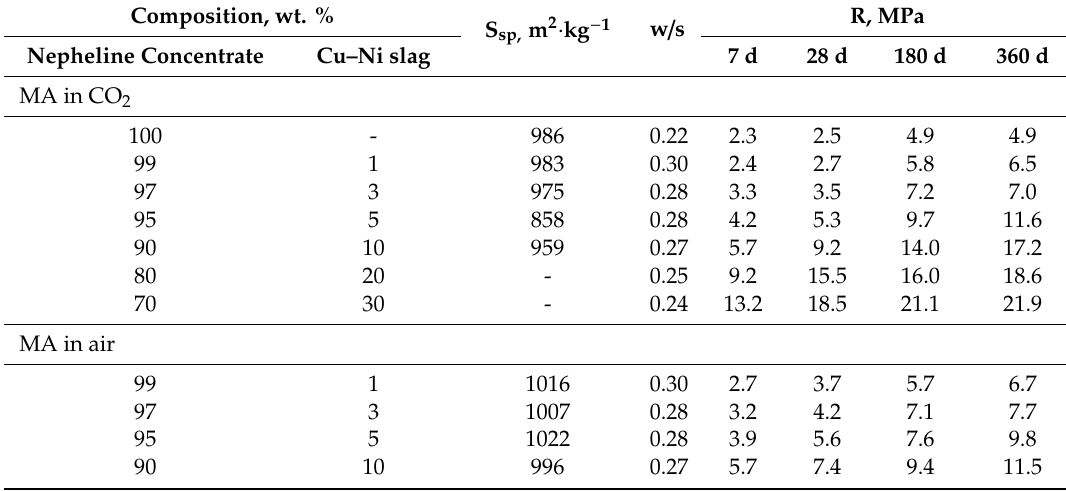
Table 5. The compressive strength (R) of the NC–Cu–Ni slag–liquid glass binder. MA was carried out for 270 s. Liquid glass contained 2.68 wt. % Na 2 O relative to weight of the (NC + Cu–Ni slag) mixture; silica modulus of liquid glass was 1.59. Curing was carried out under relative humidity of 95 ± 5% at temperature of 20–22 ◦ C (w / s: water to solid ratio; S sp : the specific surface area of the NC–Cu–Ni slag